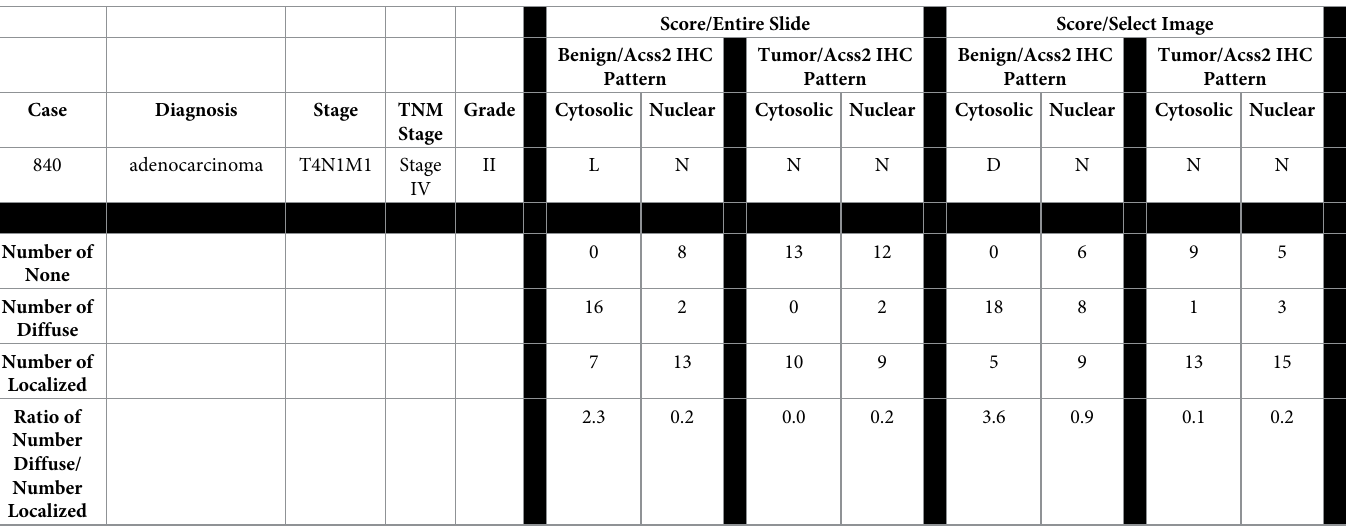
pattern in both the cytosolic and nuclear compartments for benign tissue and tumor samples. A ratio of diffuse/localized scores was then calculated for each subcellular compartment. A high diffuse/localized ratio indicates a preferential diffuse Acss2 expression